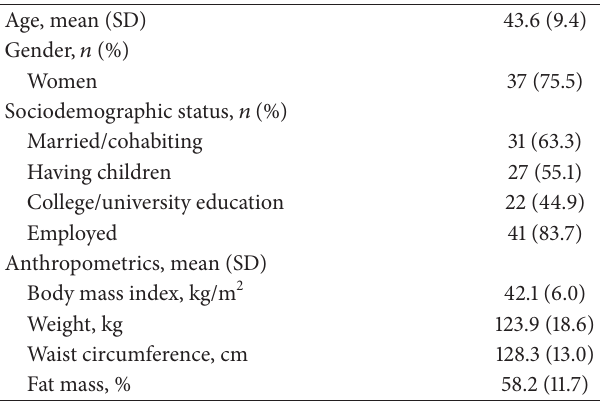
Table 1: Characteristics of the adults with severe obesity at baseline, 𝑁 = 49